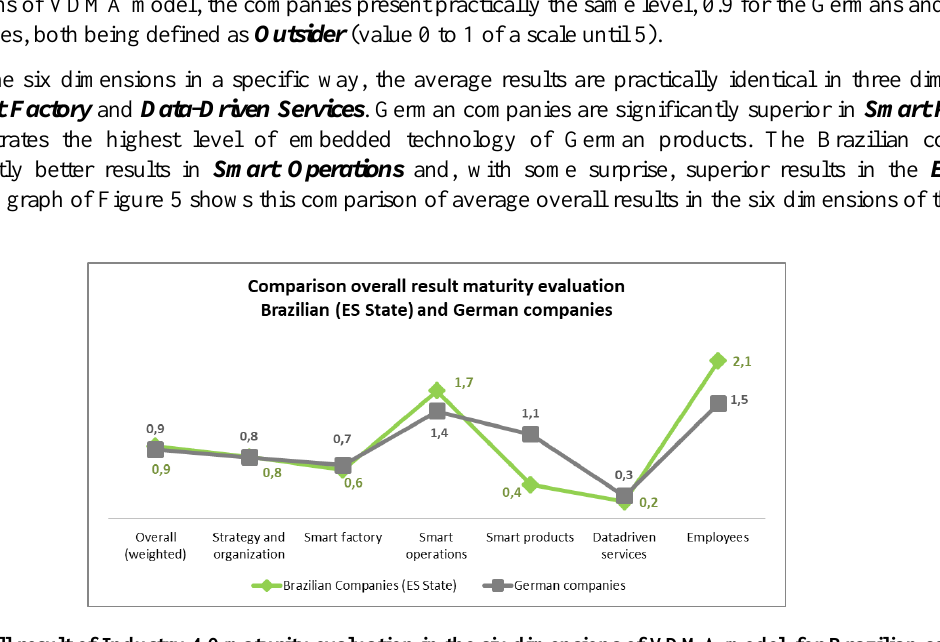
Figure 5. Overall result of Industry 4.0 maturity evaluation in the six dimensions of VDMA model, for Brazilian companies and German Industry.